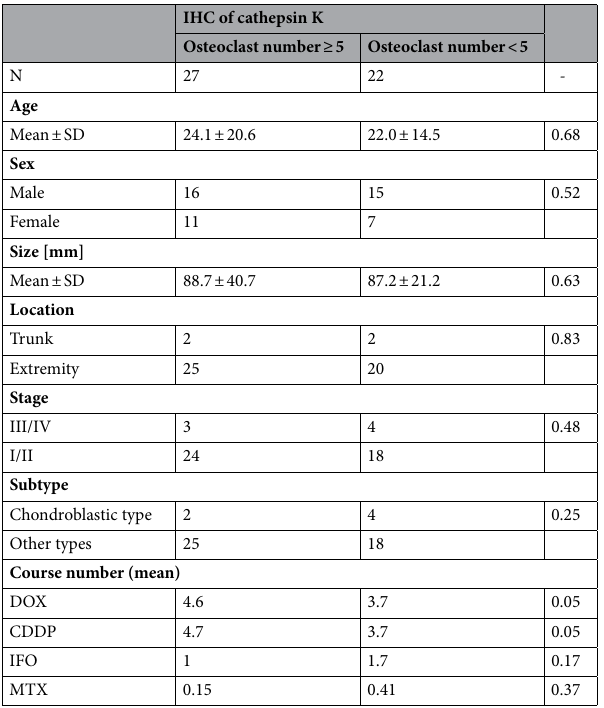
IHC of cathepsin